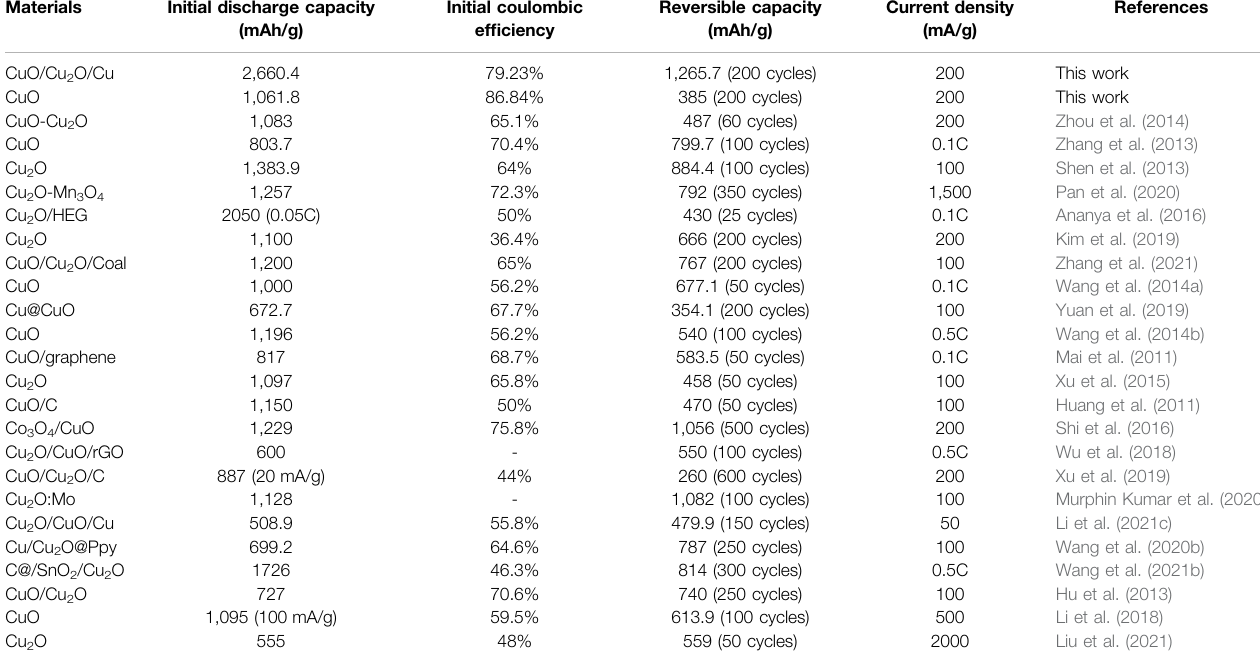
TABLE 1 | The list of electrochemical results in this work and some reported results of copper-based oxides.